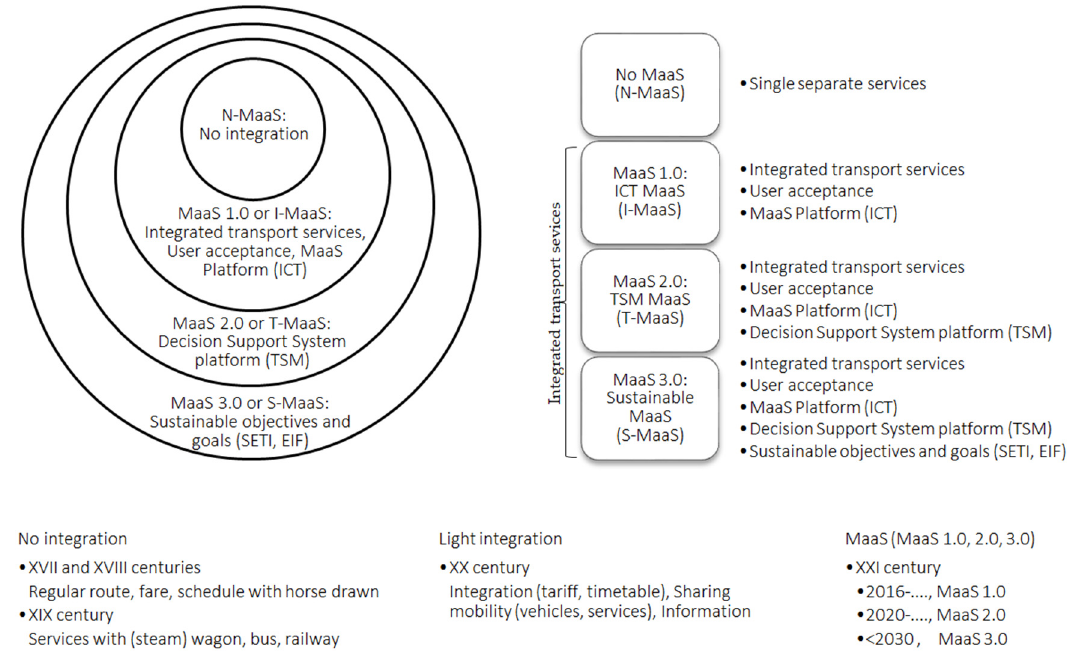
Figure 2. MaaS in relation to the integration, methods adopted for design, management and monitoring of the transport services.